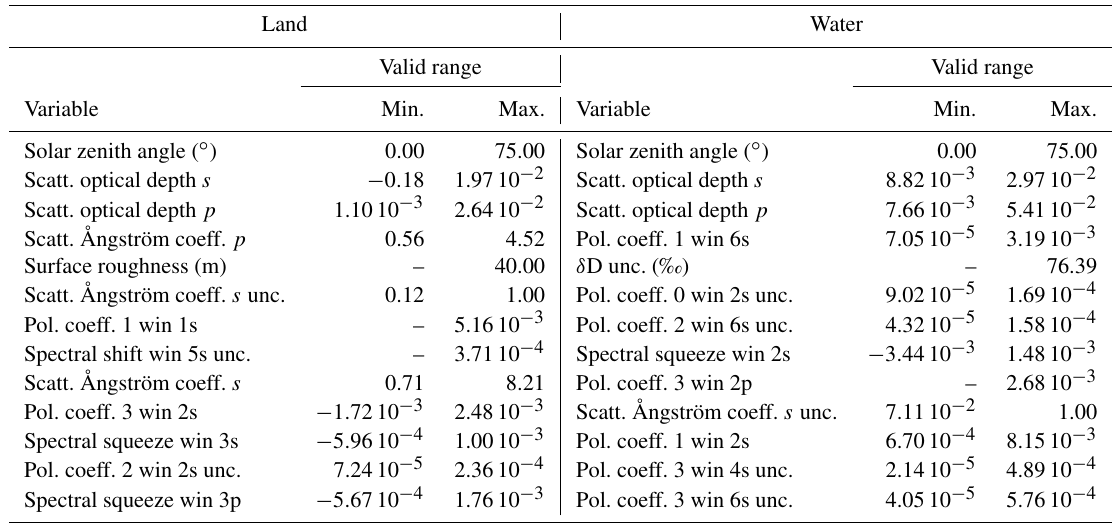
Table A6. XCO 2 filter variables and limits for GOSAT-2. “–” means that no limit is applied. Except for the solar zenith angle limits, the variables are ordered by their relevance, i.e. by the number of data filtered out.